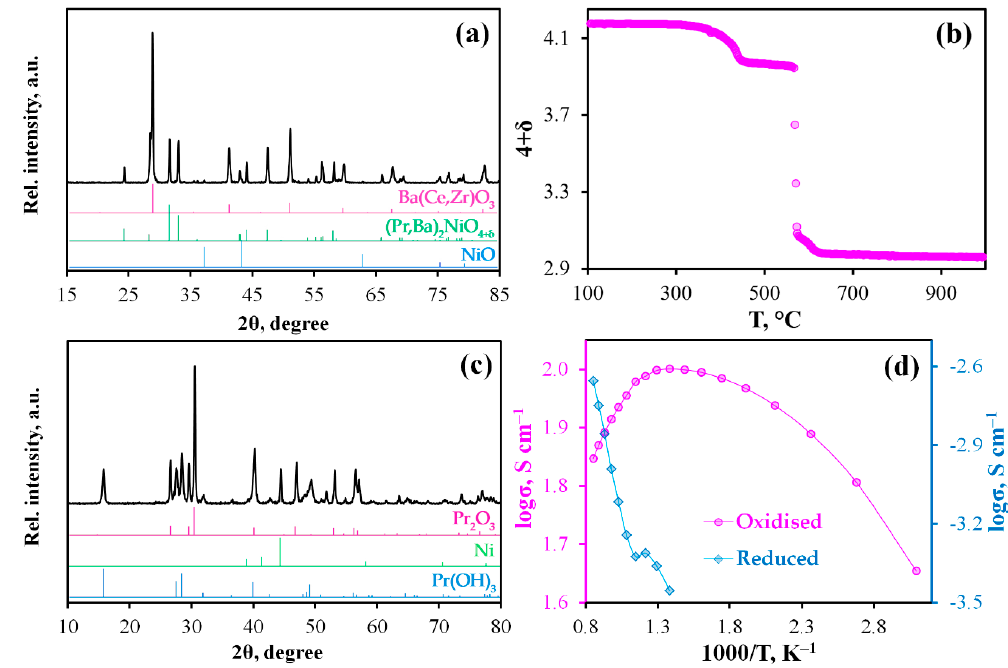
Figure 2. ( a ) XRD pattern of the BCZD – PBN mixture calcined at 1350 °C for 5 h; ( b ) TG curve obtained under reduction of the PBN powder in 50%H 2 /N 2 atmosphere; ( c ) XRD pattern of the reduced product of the PBN material (after TG analysis); ( d ) Conductivity of the PBN samples in oxidizing and reducing atmospheres.